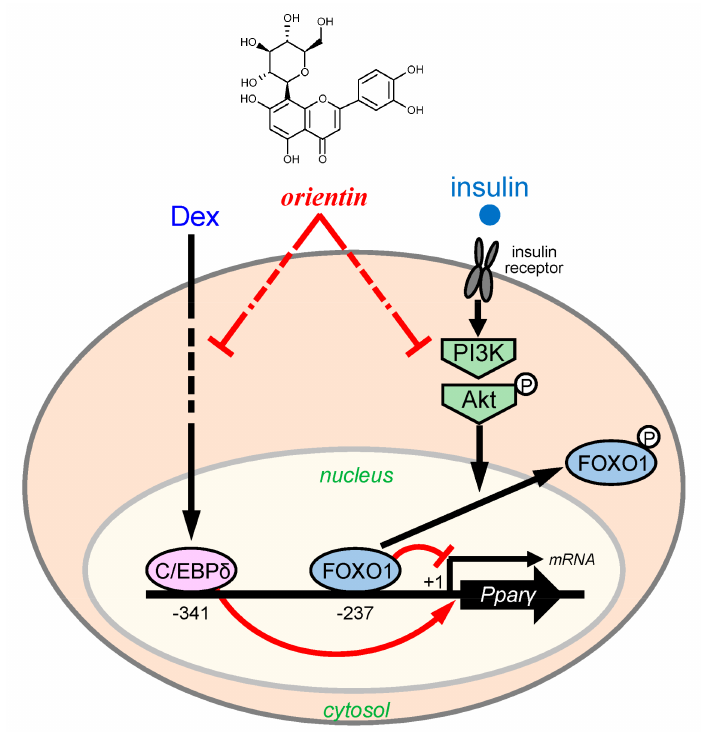
Figure 9. Proposed mechanism of orientin-mediated suppression of adipogenesis in 3T3-L1 cells. C/EBP- and FOXO-binding elements were shown at − 341 and − 237, respectively. Transcription initiation site of the Ppar γ 2 mRNA was defined as